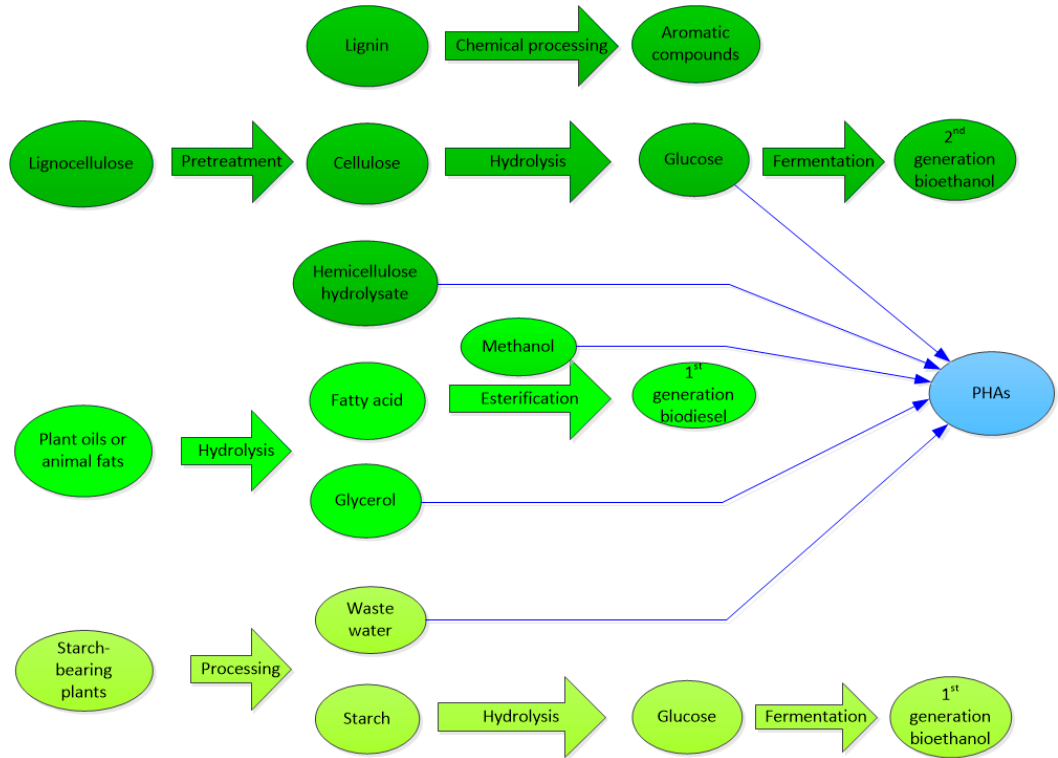
Figure 6. Integration of the production of PHAs into a modern biorefinery from lignocellulose (dark green), plant oils or fats (medium green) and plant starch (pale green)